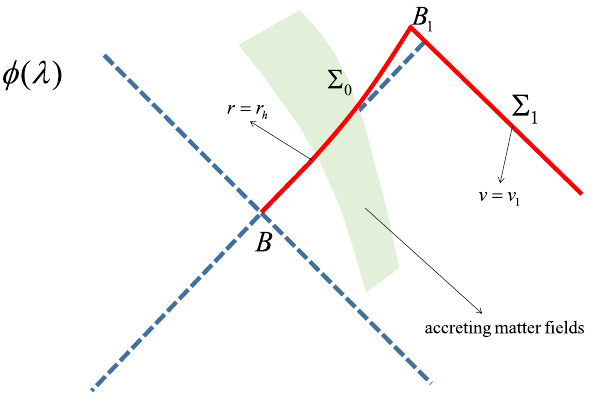
Fig. 1 Plot showing a dynamical configuration φ(λ) where the static nonextremal black hole is perturbed by the spherically accreting mat- ter fields. (cid:15) 0 is a hypersurface determined by r = r h , where r h is the horizon radius of the background geometry φ( 0 ) . Different from the hypersurface H in [25], (cid:15) 0 is not a null hypersurface in the configura- tion φ(λ) with the line element ds 2 (λ) because r h is only the horizon radius of the background